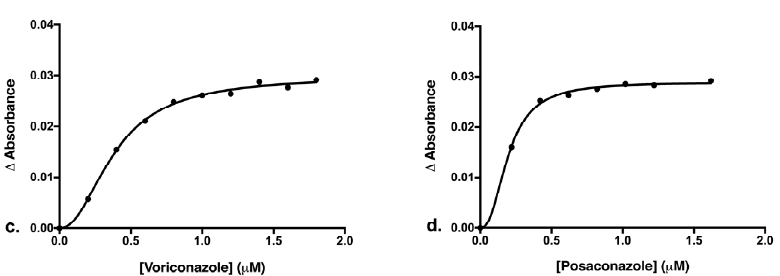
Figure 5. Binding of triazoles VCZ and PCZ to CnCYP51-6 × His. VCZ was dissolved in Milli-Q water and PCZ was dissolved in DMSO and each titrated against 1 μ M CnCYP51. ( a ) Type II difference spectra with VCZ. ( b ) Type II difference spectra with PCZ. ( c ) Saturation curve for VCZ binding fitted using the Hill equation. ( d ) Saturation curve for PCZ binding fitted using the Hill equation.